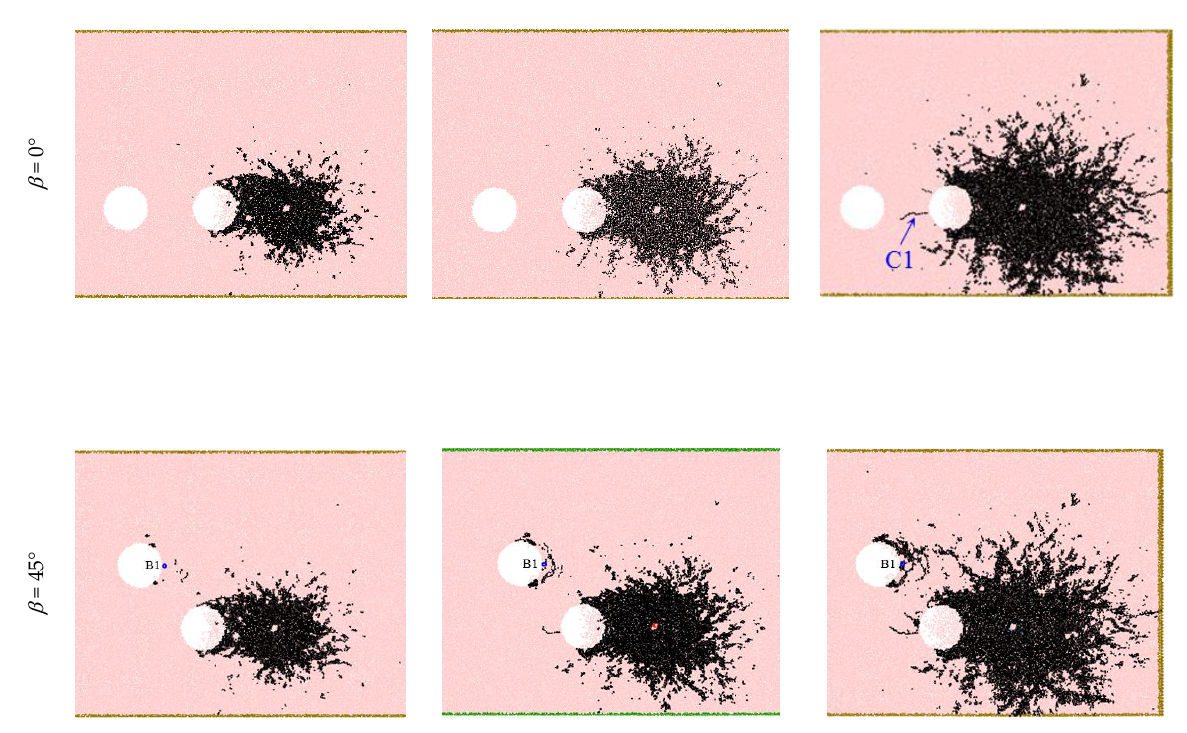
Figure 11. Dynamic stress amplification factor under various tunnel dips and wavelengths: ( a ) B1; ( b ) B2; ( c ) B3; ( d ) B4. ( b ) B2; ( c ) B3; ( d ) B4.